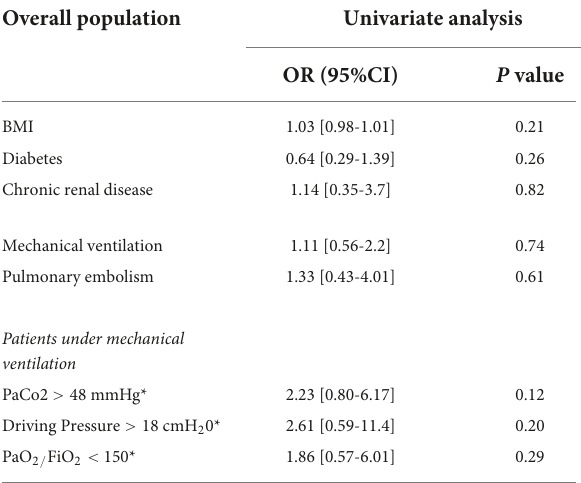
TABLE 4 Factors associated with acute cor pulmonale in patients with COVID-19-related pneumonia.